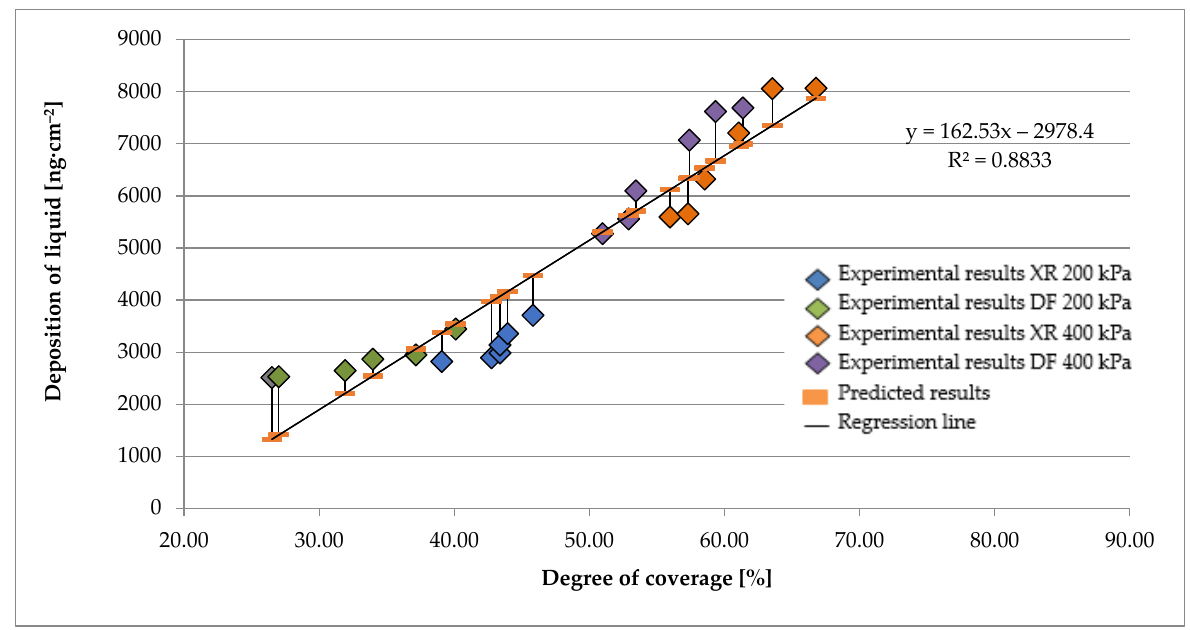
Figure 4. The scatter plot of the degree of coverage and deposition of spray liquid for selected standard nozzles for upper horizontal surface.